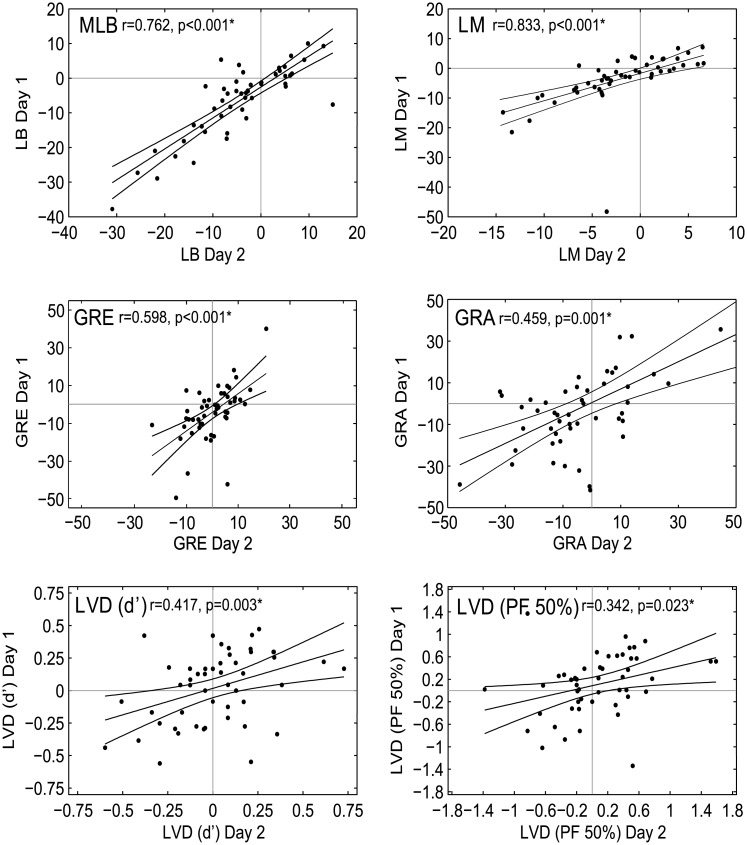
Intra-task correlations.Day 1 vs Day 2 biases are significantly correlated for all 5 tasks (i.e. each task provides a stable measure) over the two testing days (all p-values <0.05). Line of best fit and 95% confidence intervals are marked. * represents a significant correlation at α = 0.05.